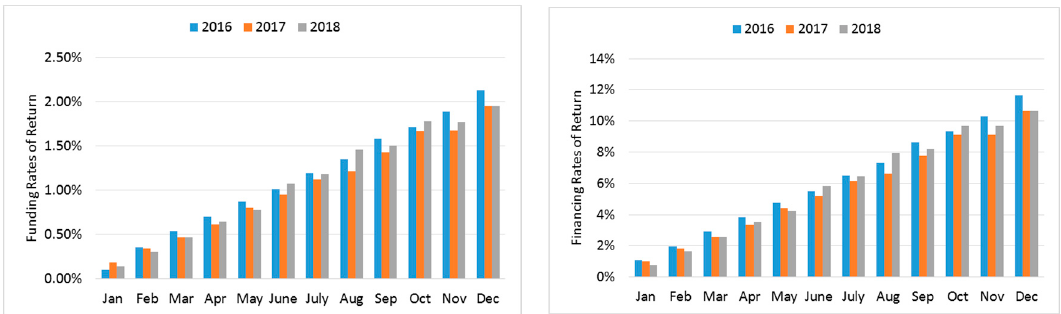
Figure A4. Rates of return for Funding ( left ) and financing ( right ) funds from Bank A.